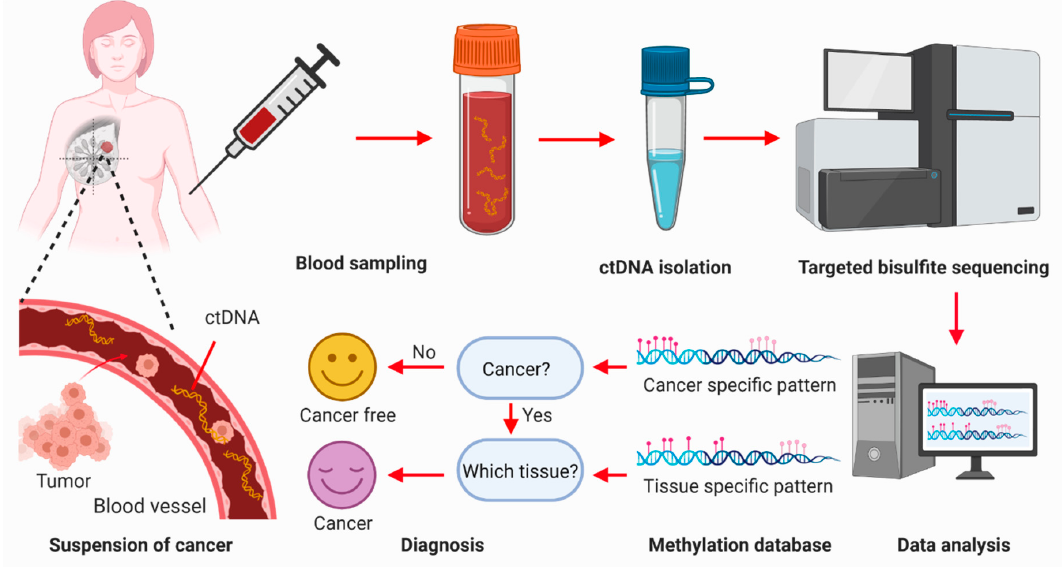
Figure 2. Diagram of the procedures of breast cancer detection through methylation patterns of circulating cell-free DNA in the blood. Breast tumor and normal tissue shed DNA fragments into the blood. Peripheral blood is withdrawn from human subjects and circulating tumor DNA ( ctDNA ) is isolated from the blood sample. The methylation status of the ctDNA is determined by targeted bisulfite methylation sequencing. The methylation patterns of the ctDNA fragments are analyzed. The presence or absence of cancer cells is thus determined by comparing the methylation patterns with those in the methylation database, which is constructed from those individuals with and without cancer. The origin of cancer is determined using unique tissue-specific methylation patterns. Figures were created with BioRender.com (https://biorender.com/) .